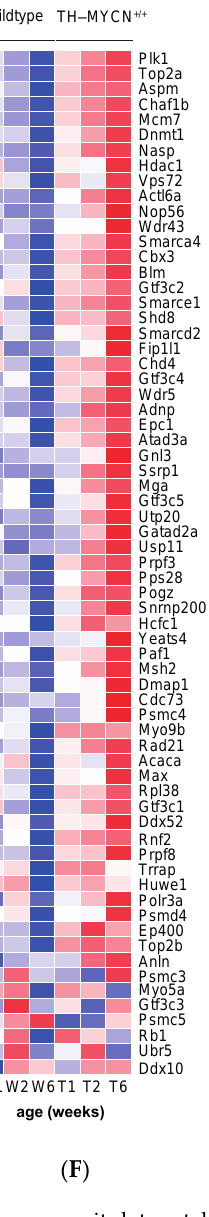
Figure 1. Time-resolved transcriptome data of murine TH-MYCN driven neuroblastoma tumors recapitulate established gene signatures. ( A ) Principal component analysis visualizing the variation in the dataset with PC1 discriminating the genotypes and PC2 the age of mice. ( B ) Heatmap showing the expression of 50 genes out of a total of 140 genes, previously reported as oncogenes, codrivers or tumor suppressor genes, that are the strongest up- (left) or downregulated (right) in TH-MYCN +/+ compared to wild type upon 6 weeks after birth. Each instance in the heatmap represents mean expression of 4 samples. Heat color reflects row-wise z -score. ( C ) Signature score analysis of MYCN activity in the hyperplasia dataset. Data represent mean signature score ± standard deviation of 4 samples. y -axis represents the ranks. Gray : TH-MYCN +/+ samples; black : wild type samples. p -value corresponds to the interaction term of a two-way ANOVA analysis. ( D ) Signature score analysis of early and late neuronal sympathetic differentiation in the hyperplasia dataset. Data represent mean signature score ± standard deviation of 4 samples. y -axis represents the ranks. Gray : TH-MYCN +/+ samples; black : wild-type samples. p -value corresponds to the interaction term of a two-way ANOVA analysis. ( E ) Signature score analysis of adrenergic and mesenchymal differentiation in the hyperplasia dataset. Data represent mean signature score ± standard deviation of 4 samples. y -axis represents the ranks. Gray : TH-MYCN +/+ samples; black : wild-type samples. p -value corresponds to the interaction term of a two-way ANOVA analysis. ( F ) Heatmap showing the expression of differentially expressed MYC (N) interacting proteins in TH-MYCN +/+ compared to wild-type samples upon 6 weeks of birth. Each instance in the heatmap represents mean expression of 4 samples. Heatmap colors reflect the row-wise z